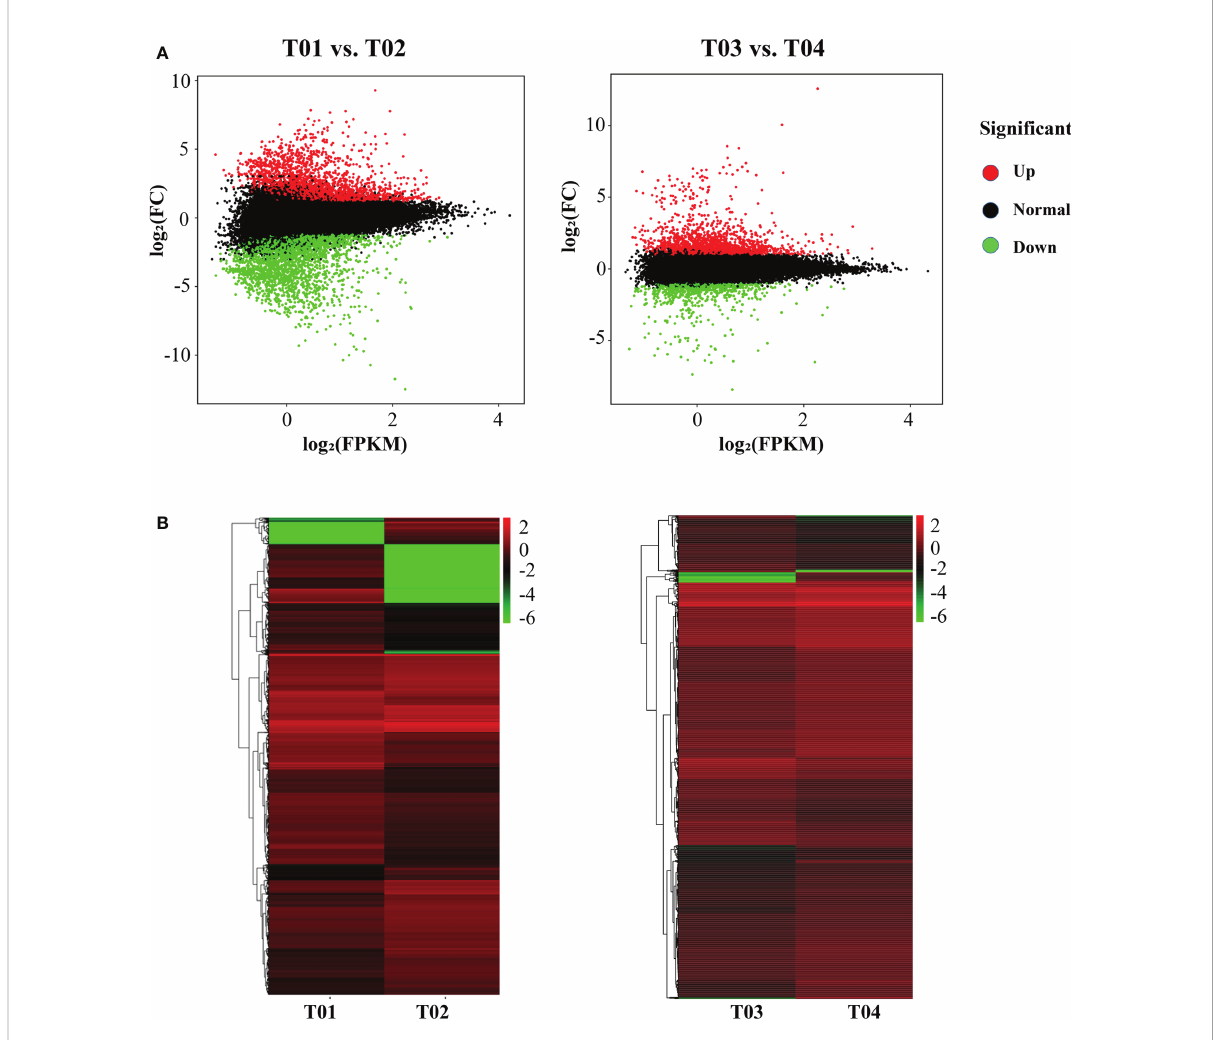
FIGURE 3 MA plot (A) and cluster plot (B) of differentially expressed genes (DEGs) between YT93-159 (T01) and ROC22 (T02) and between the resistant bulk (T03) and the susceptible bulk